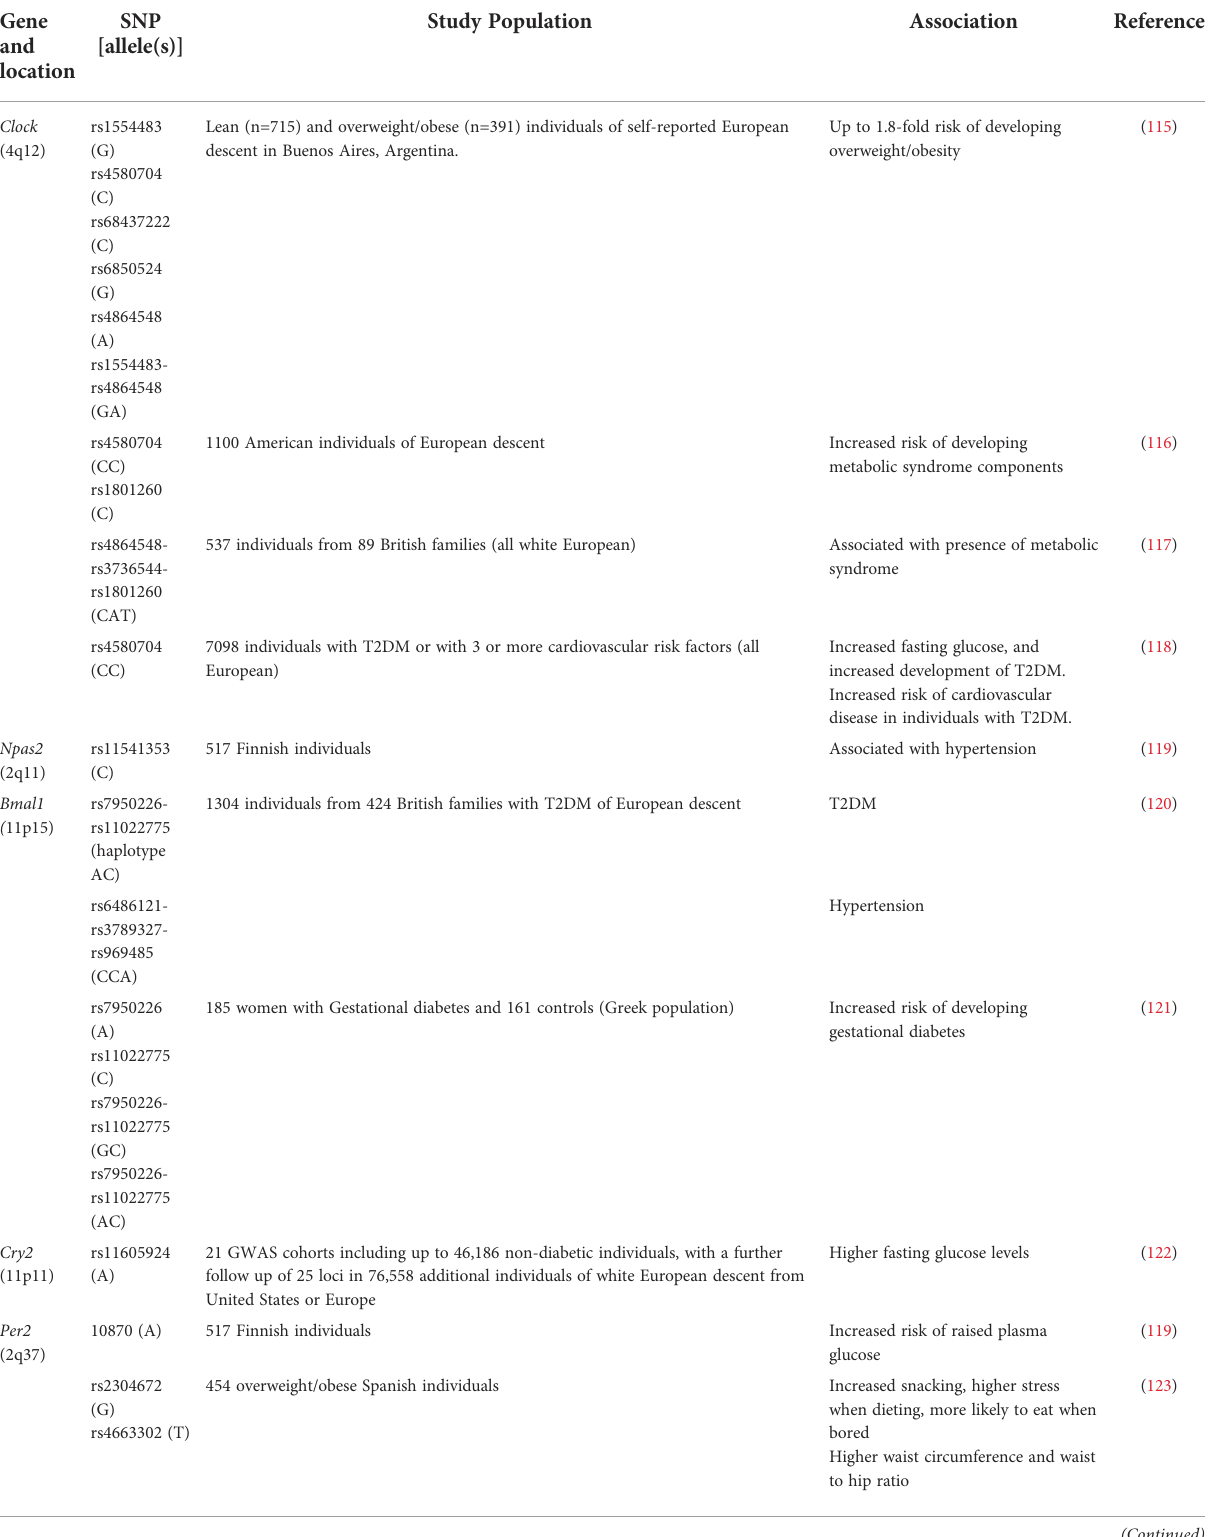
TABLE 1 SNPs in circadian rhythm-related genes associated with metabolic dysfunction, obesity and T2DM in humans. Gene SNP and [allele(s)] location Lean (n=715) and overweight/obese (n=391) individuals of self-reported European descent in Buenos Aires, Argentina.